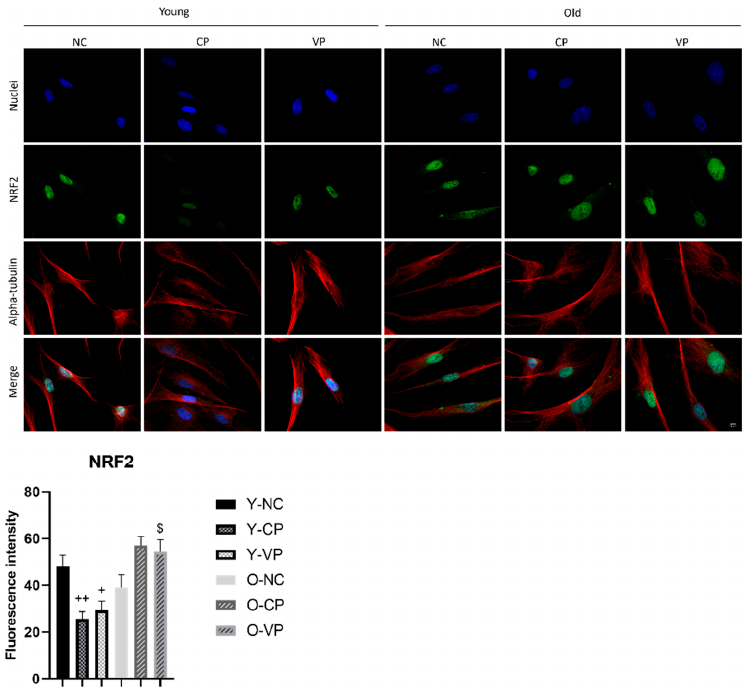
Figure 3. Double immunolabelling for Nrf2 protein (green fluorescence) and alpha-tubulin (red fluorescence); DNA was stained with Hoechst 33258 (blue fluorescence). Magnification: 60×; scale bar: 10 μ m. Histograms representing the analysis of the fluorescence intensity of Nrf2; Anova one-way test: p < 0.0001; ++ p < 0.01, statistical significance between untreated young NHDF (Y-NC) and young NHDF treated with CP extract (Y-CP); + p < 0.05, statistical significance between young NHDF treated with VP and negative control; $ p < 0.05, statistical significance between old NHDF treated with VP extract and old NHDF untreated.